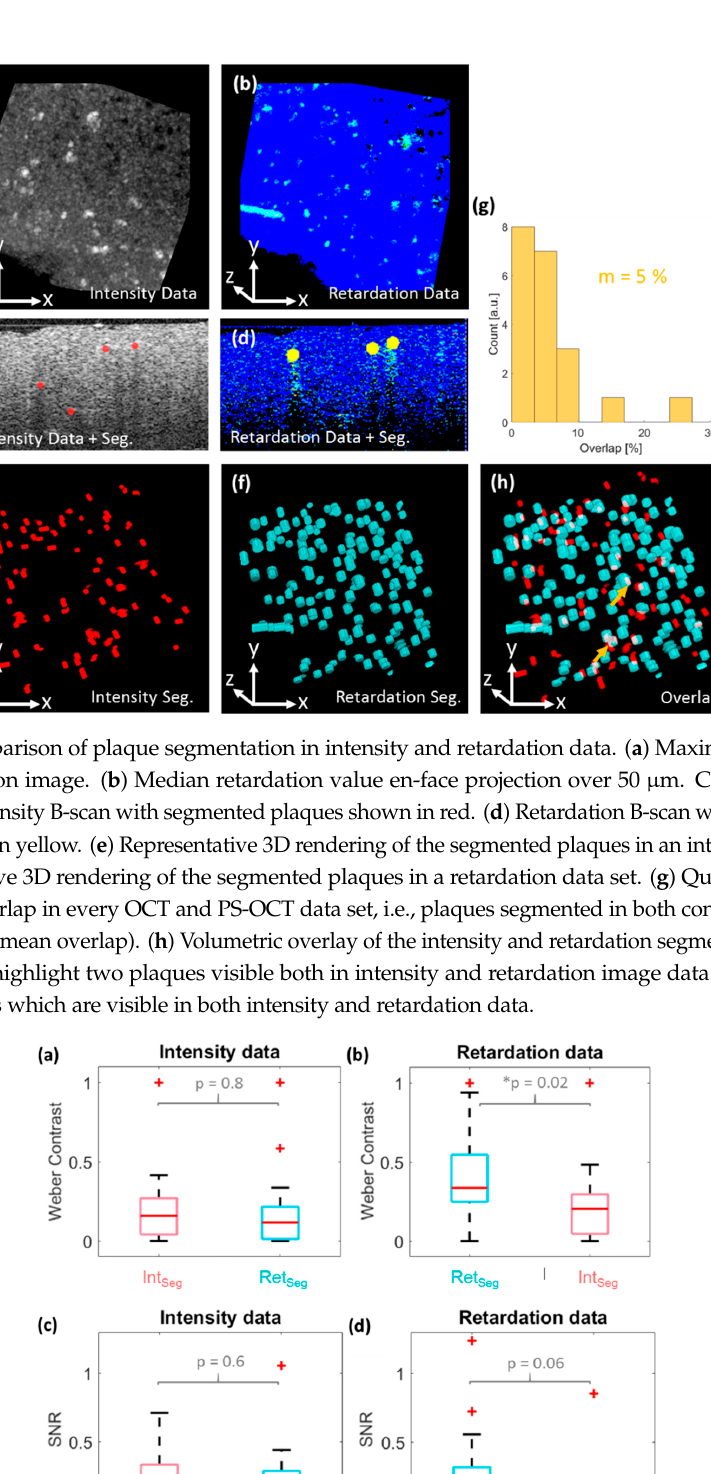
Figure 4. Overview of plaques segmented in the OCT data sets of eleven patients in 500 µm × 500 µm × 500 µm fields of view (FOV). ( a ) Plaque count in retardation and intensity data including the overlapping plaques (i.e., plaques observed both in intensity and retardation images) plotted for